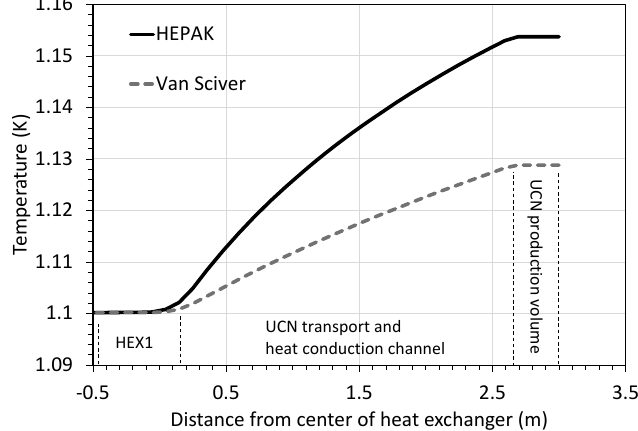
Figure 2. Temperature profile inside the He-II of the heat conduction channel in the TRIUMF UCN source according to two parametrizations of Gorter-Mellink heat transport: Van Sciver [14] and HEPAK